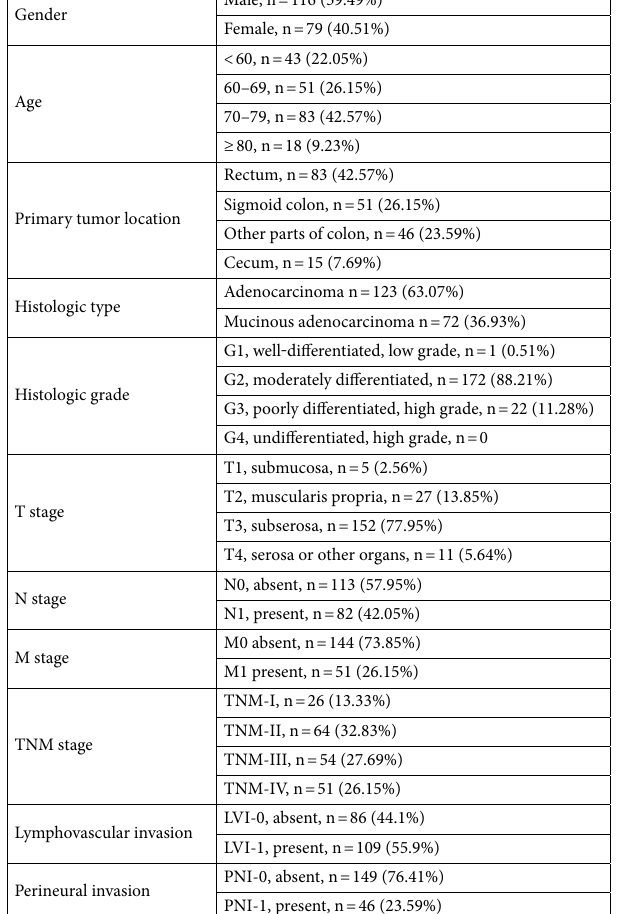
Table 1. Clinical characteristics of the study group (n = 195).